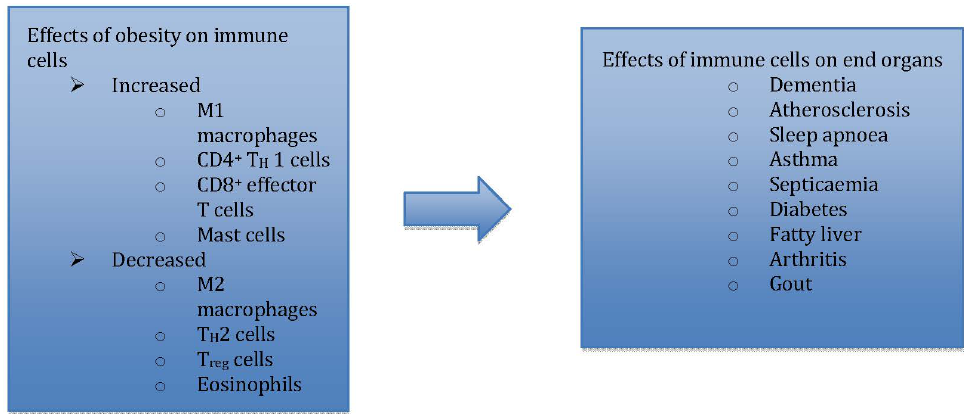
Figure 1. Immunometabolism explores how immune changes are translated to metabolic effects in end